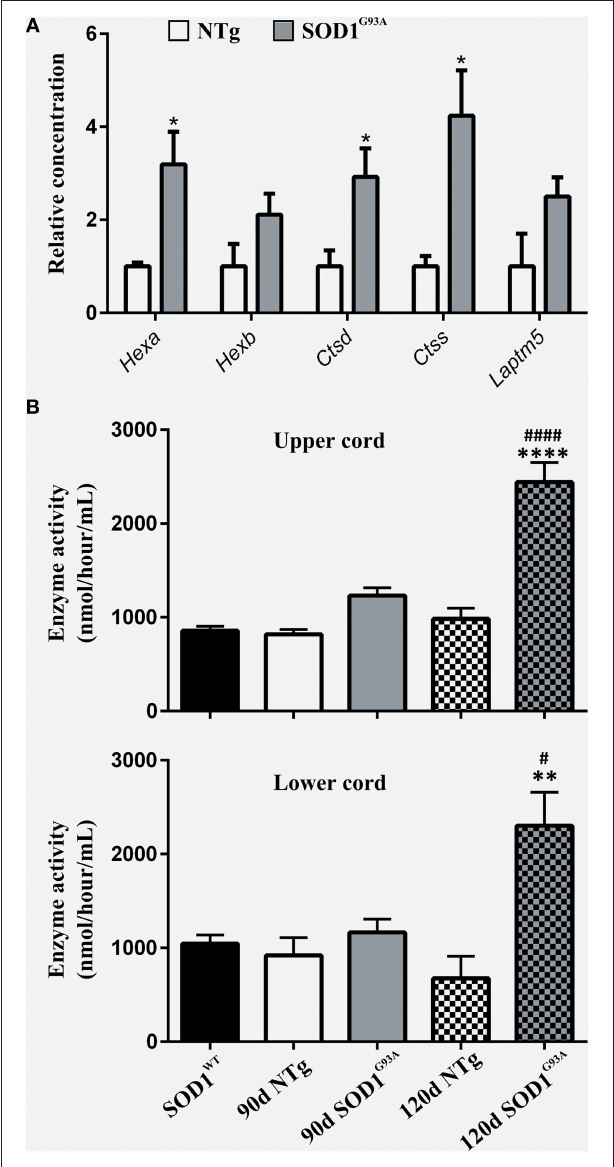
FIGURE 1 | (A) qPCR upon symptomatic RNA of five lysosomal transcripts differentially expressed on symptomatic and late-stage microarrays; n = 3 per group. (B) Enzyme activity of Hexosaminidase B in the upper and lower spinal cord of SOD1 WT , SOD1 G93A , and NTg controls (SOD1 WT , 90d NTg, and 90d SOD1 G93A : n = 3 , 120d NTg and 120d SOD1 G93A : n = 4 ). Error bars = S.E.M. * p ≤ 0.05 , ** p ≤ 0.01 , **** p ≤ 0.0001 vs. age-matched